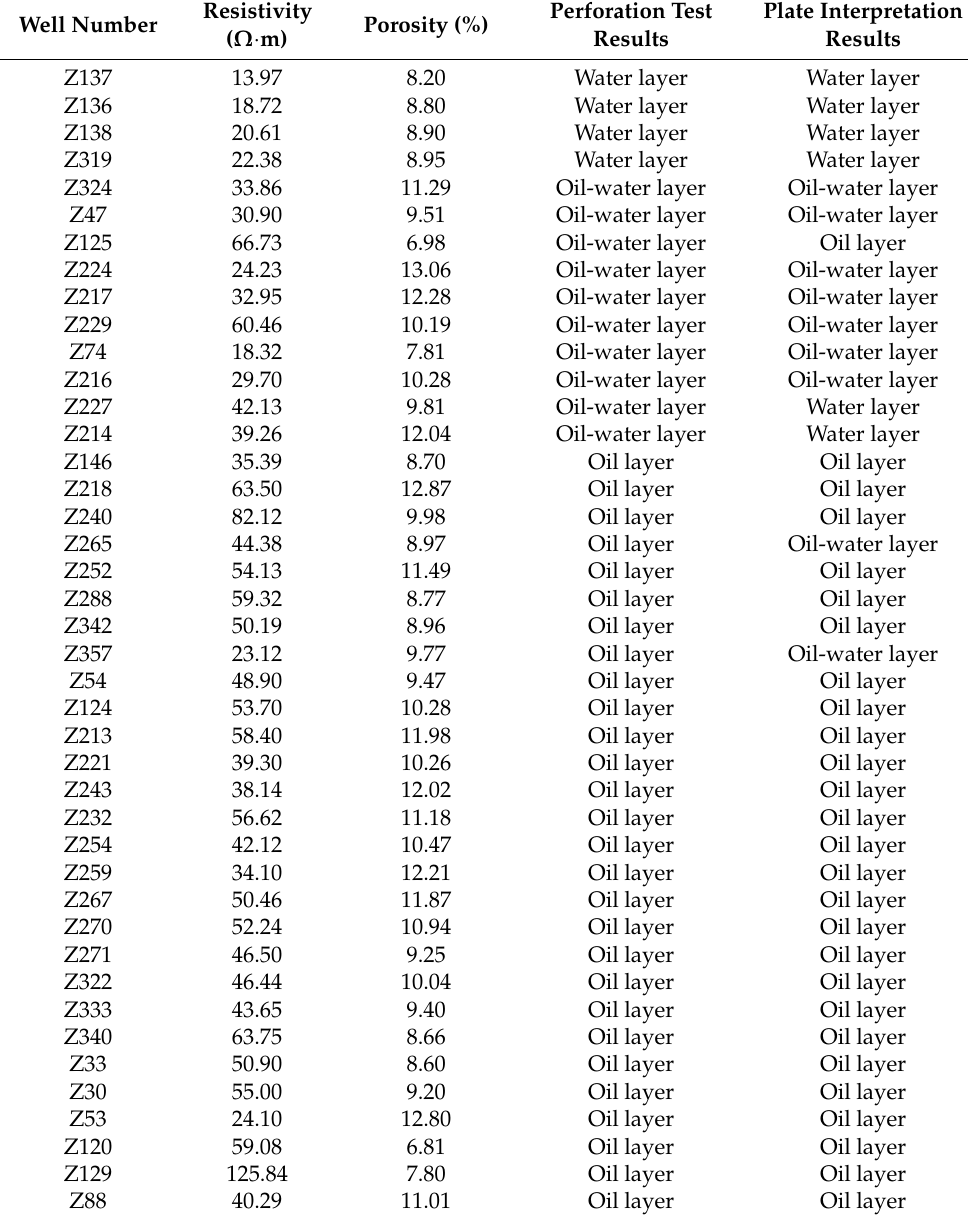
Table 4. Basic plate verification